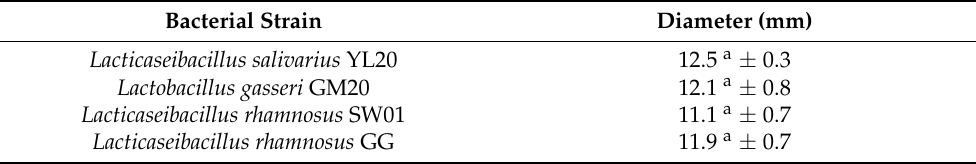
Table 3. Antagonistic activity of lactic acid bacteria against C. sakazakii .